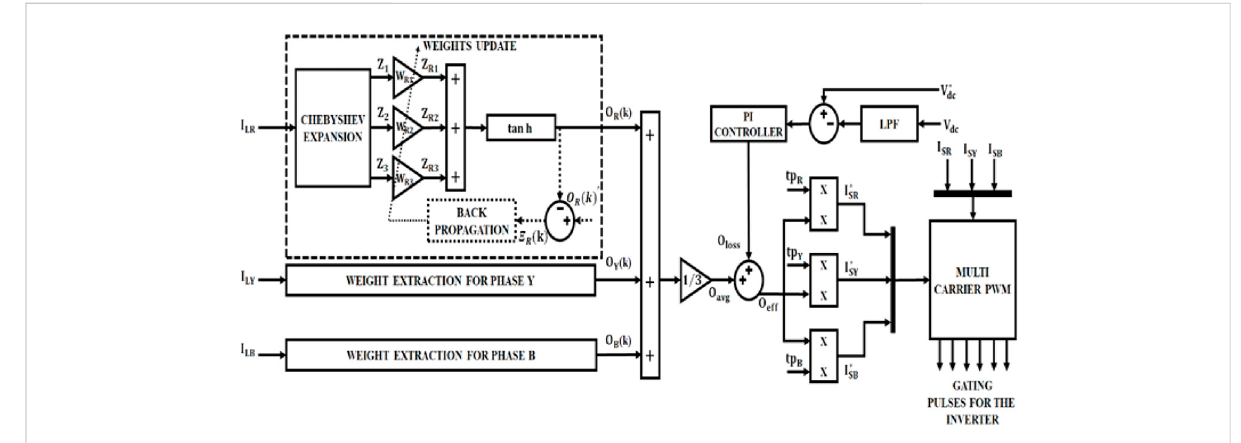
FIGURE 6 Illustration of the ChNN